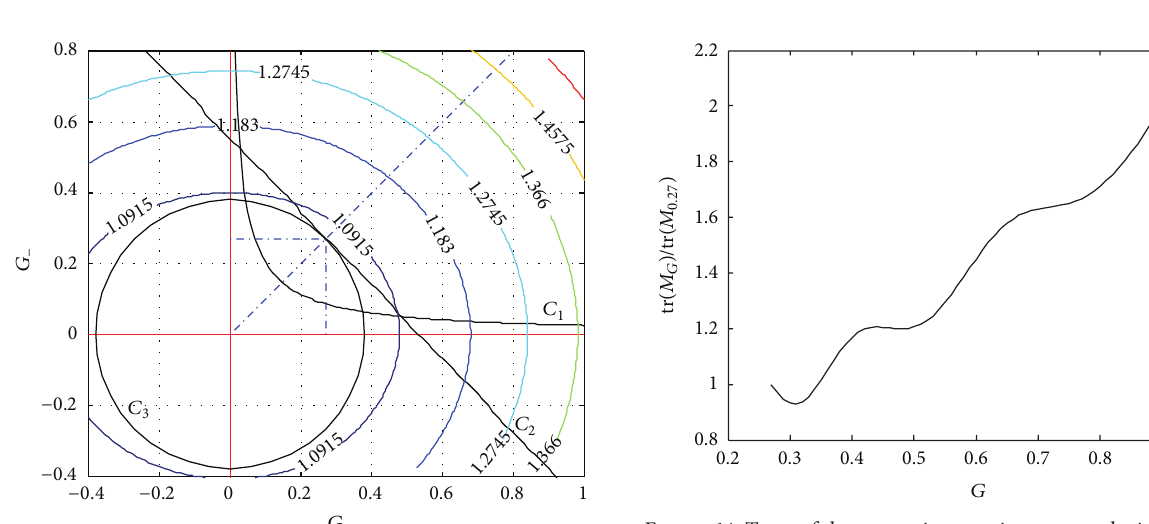
(80.5%) for the position feedback. While for full